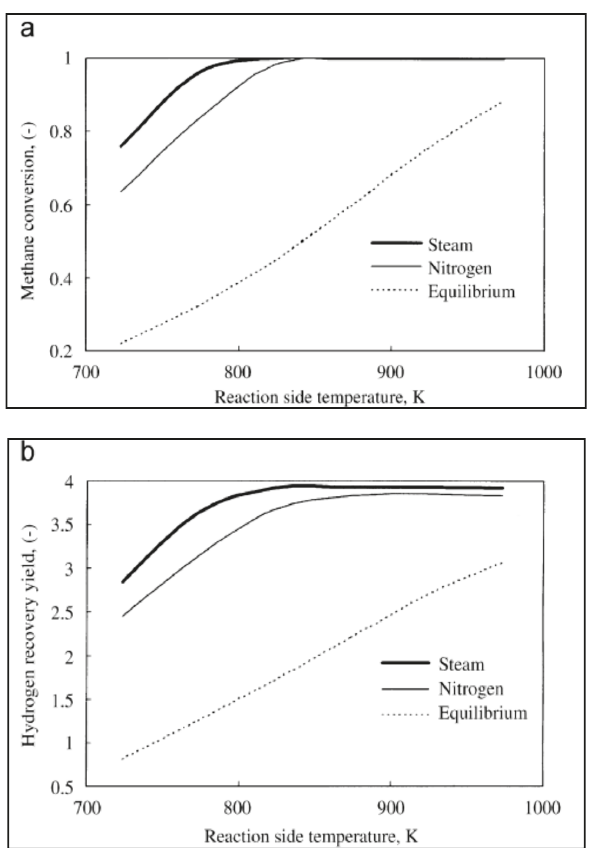
Figure 9. Effects of different sweep gas utilization on silica MR performance: ( a ) methane conversion vs reaction temperature; ( b ) hydrogen recovery vs reaction temperature. With permission of reprint from Elsevier by Yu et al. [39].